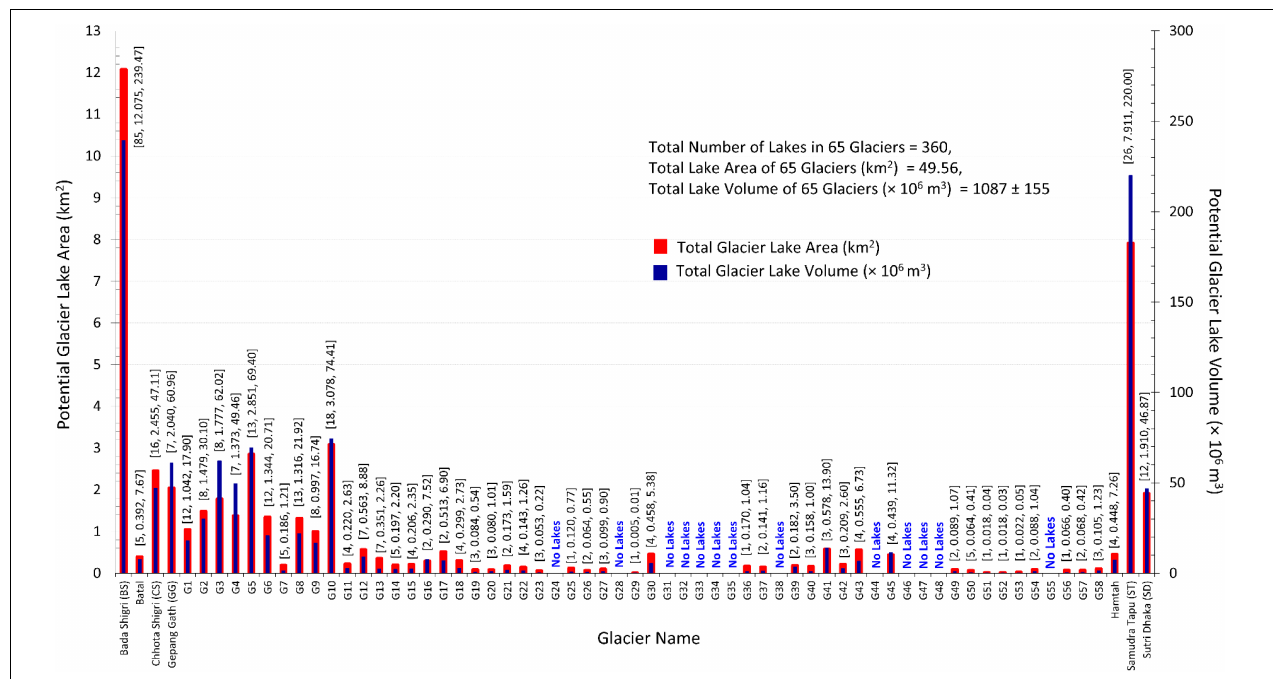
FIGURE 9 | Glacier-wise number, total area, and volume of PFGLs in all 65 study glaciers. Information associated with each bar is arranged as [number of lakes, total lake area (km 2 ), total lake volume (km 3 )] Table 5 provides the area and storage volume of the largest PFGL in each elevation zone. Such elevation-based knowledge of lakes would greatly benefit the policymakers and disaster management authorities in preparing mitigation policies well in advance. In the context of GLOF hazards associated with future lake development, the authorities can devise strategies to continuously monitor the locations of PFGLs, especially in Gepang Gath, Bada Shigri, G41, and G6 Glaciers ( Table 5 ).